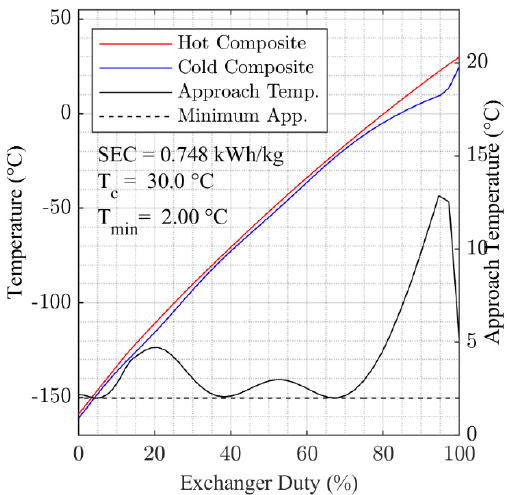
Figure A6. Optimized composite cooling curves for 30°C cooling temperature.